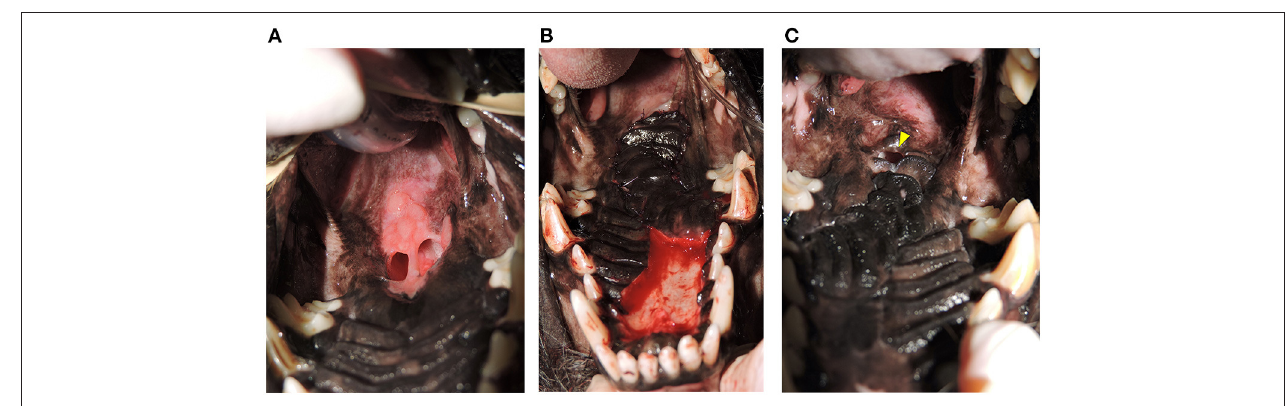
FIGURE 4 | (A) Oronasal communication from eosinophilic granuloma complex. Photograph showing an oronasal communication near the junction of the hard and soft palate prior to repair. (B) Island Mucoperiosteal Flap Repair. Photograph showing the same patient from (A) after closure with an island design hard palate mucoperiosteal flap. (C) Failure of flap repair. Photograph showing the same patient from (A,B) . A persistent oronasal communication remains indicating partial failure of the island hard palate mucoperiosteal flap (arrowhead).